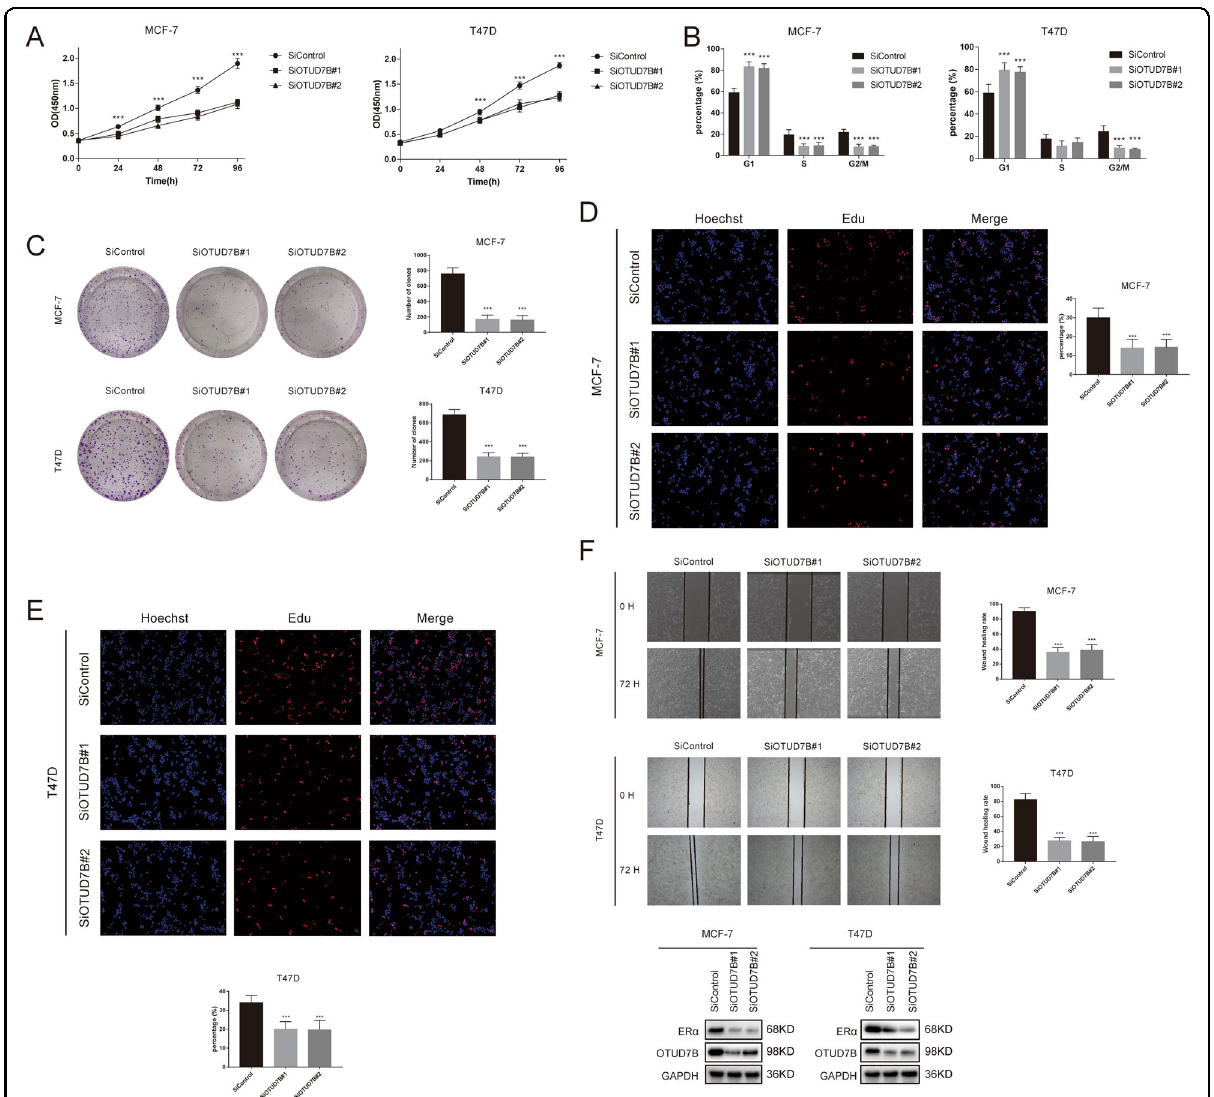
Fig. 7 OTUD7B depletion inhibits ER α -positive breast cancer cell proliferation and migration. A OTUD7B depletion inhibited cell proliferation in breast cancer cells. B OTUD7B depletion induced G1 cell cycle arrest in breast cancer cells. C OTUD7B depletion decreased clone formation capability of breast cancer cells. D , E Representative images of EdU assay of breast cancer cells. F Wound-healing assay of breast cancer cells. MCF-7- and T47D cells were transfected with indicated 50 nM OTUD7B siRNA or 50 nM control siRNA. Twenty four hours after transfection, cells were seeded into 6-well plates with 1% FBS with 100% con fl uence. A straight scratch was made on the cell layer with a yellow pipette tip. Quanti fi cation of wound closure was measured every 24 h, and the ER α protein level was measured at the endpoint. * P value < 0.05, ** P value < 0.01, *** P value <